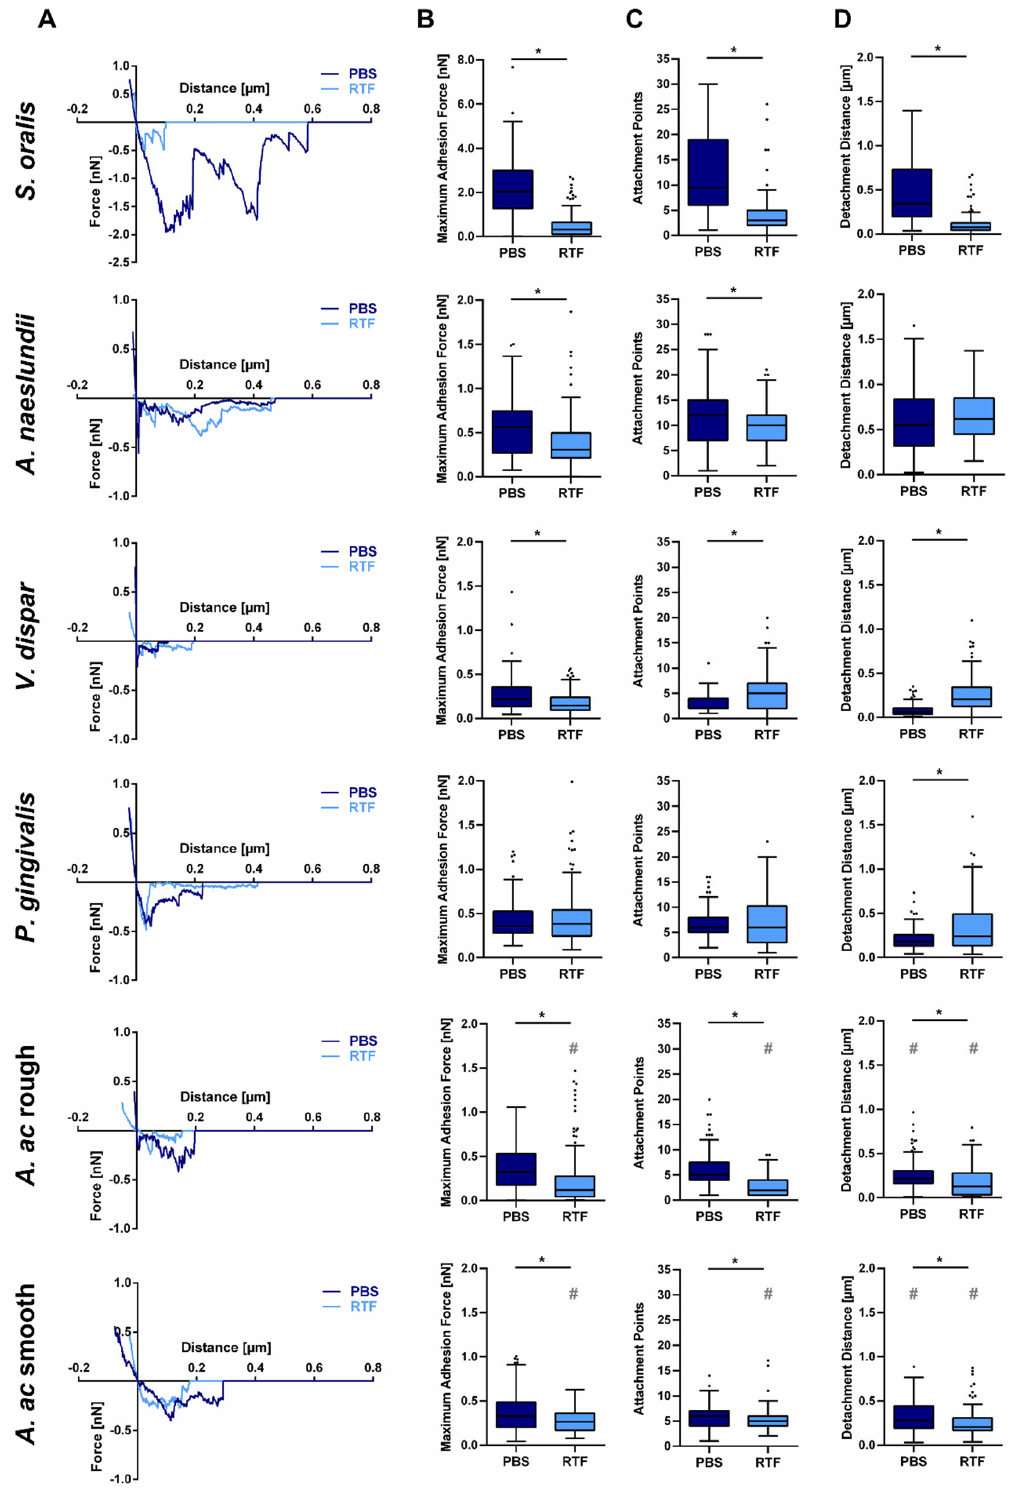
Figure 3. Single-cell adhesion forces of oral bacteria on titanium in different buffers. ( A ) Exemplary force–distance curves and Tukey boxplots of ( B ) the maximum adhesion force, ( C ) the number of attachment points and ( D ) the detachment distance of indicated strains in PBS and RTF buffer measured by SCFS with 5 s adhesion time and setpoint force of 0.75 nN. * indicates significant differences for each strain and # indicates significant differences between rough and smooth A. ac in the corresponding buffer with p ≤ 0.05 according to Mann–Whitney U-test.